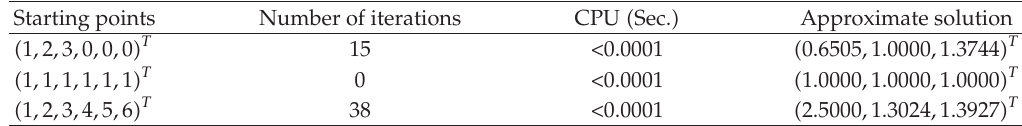
Table 3: Results for Example 6.1 using EG type HRP